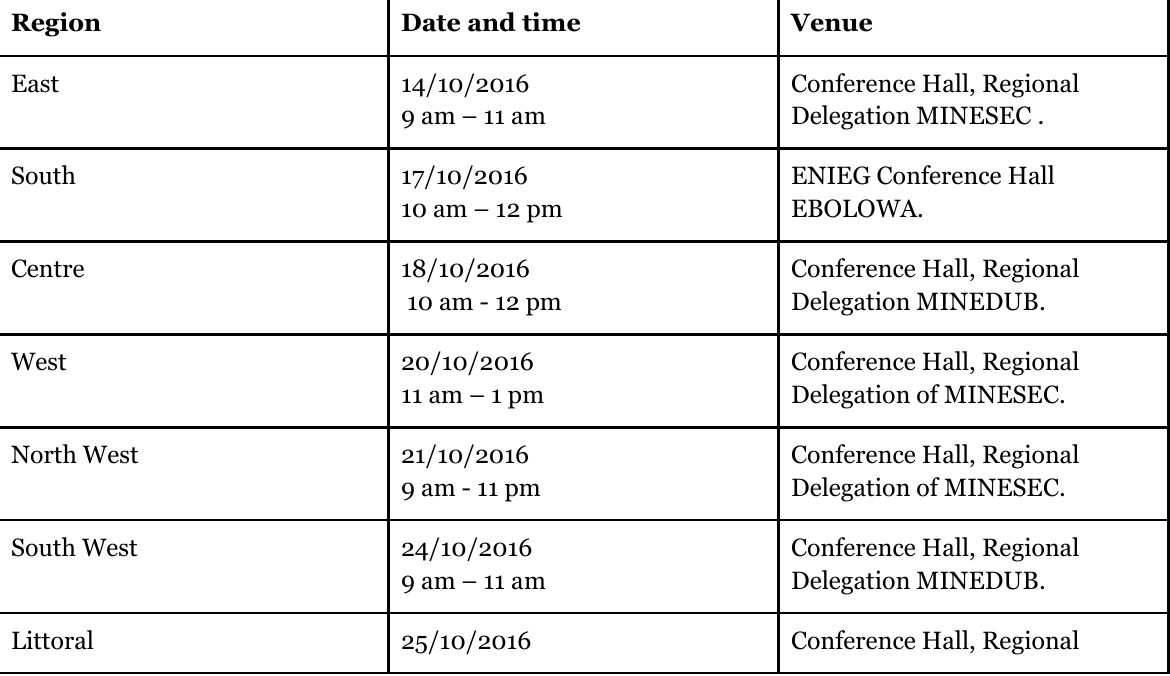
Field Visit Schedule for the 10 Regions of Cameroon